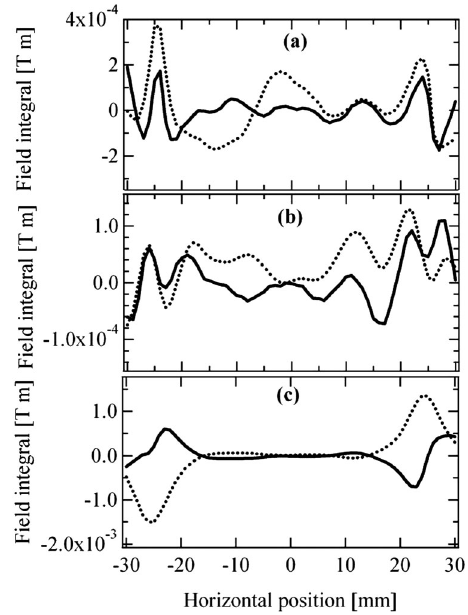
FIG. 9. Multipolar component correction: measured field inte- gral I x (a), I z (b) at minimum gap (5.5 mm) before ( . . . ) and after ( ) use of magic finger magnets. DFI correction: measured I z added to the theoretical DFI (c) at minimum gap (5.5 mm) before ( . . . ) and after ( ) use of magic finger